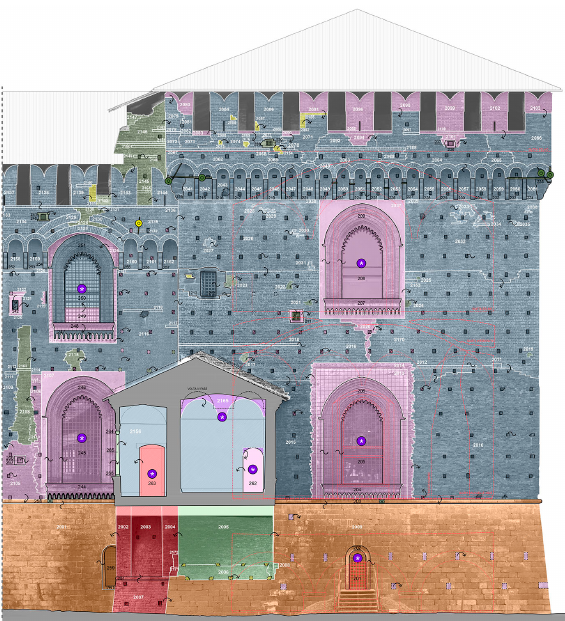
Figure 6. Stratigraphic palimpsest of the east façade.